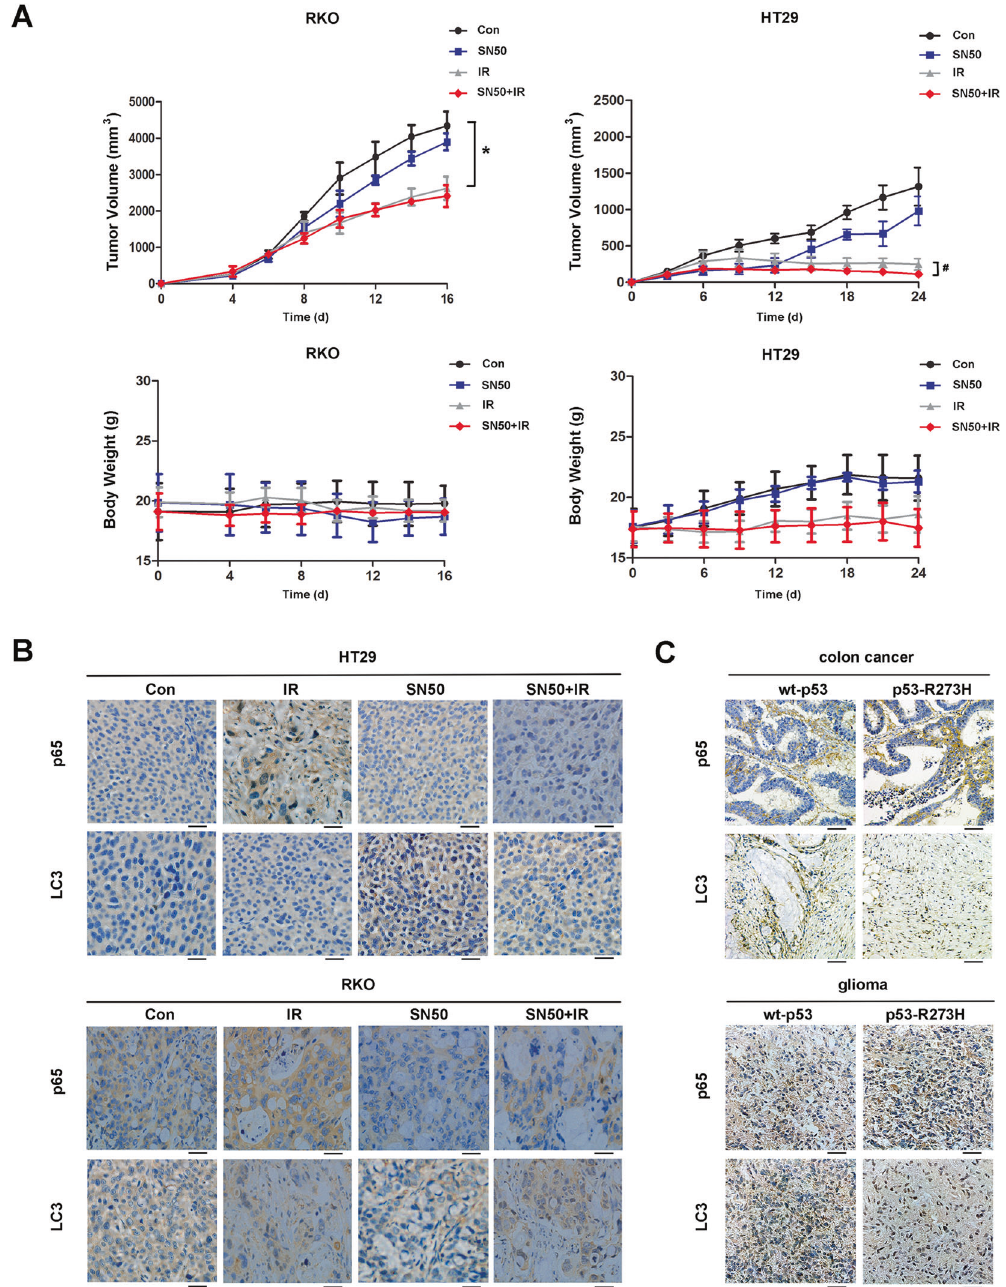
Fig. 6 Analysis of the correlation between NF- κ B and autophagy with mutant p53 in vivo. Tumor models were established for subcutaneous transplantation of RKO and HT29 cells, and local X-ray radiation treatment was performed as described in the “ Materials and methods ” after tumor formation. A The tumor size was measured using a Vernier caliper and body weight was determined using an electronic balance. B Immunohistochemical method was used to detect the changes of p65 and LC3 before and after IR in RKO and HT29 tumor models (×400). C Immunohistochemical method was used to detect the protein levels of p65 and LC3 in each tumor sample (×400) ( * P < 0.05 vs. control; # P < 0.05 compared to the IR